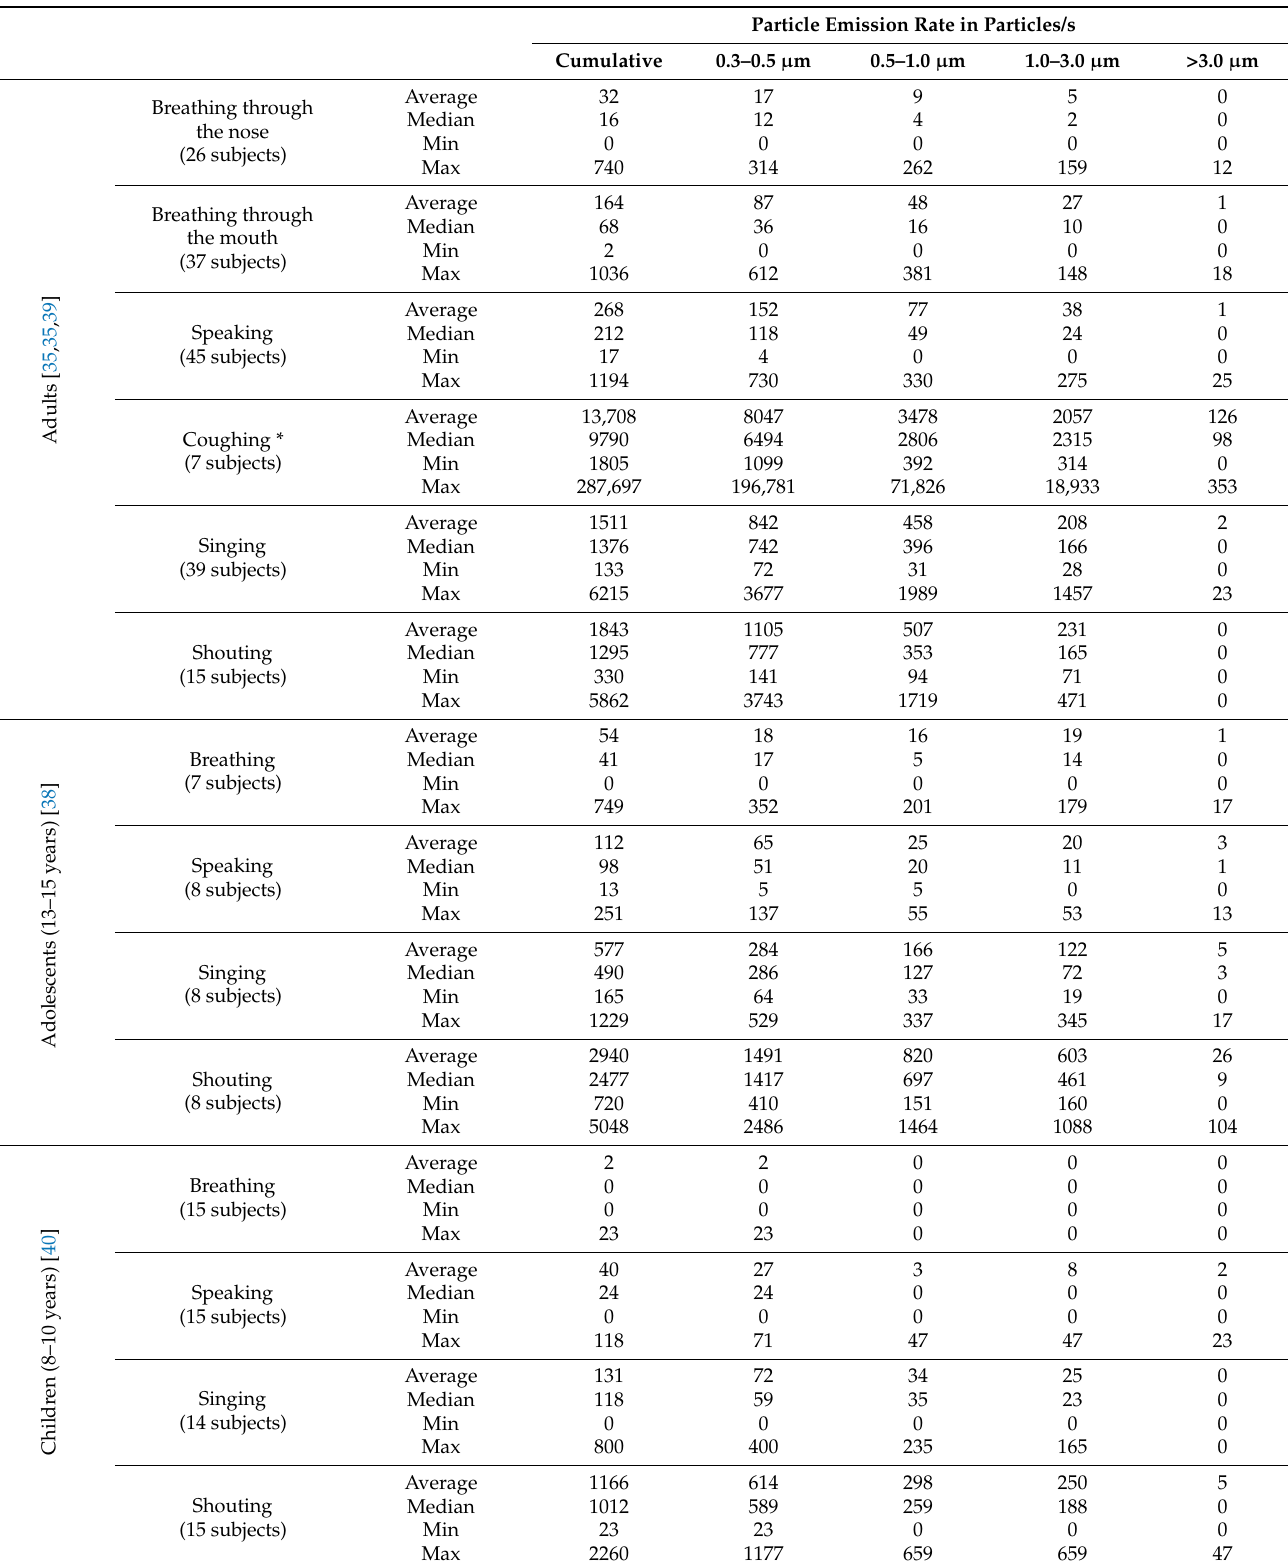
Table A1. Particle emission rates measured by the authors, partially published for adults in [34,35,39], for adolescents in [38] and for children in